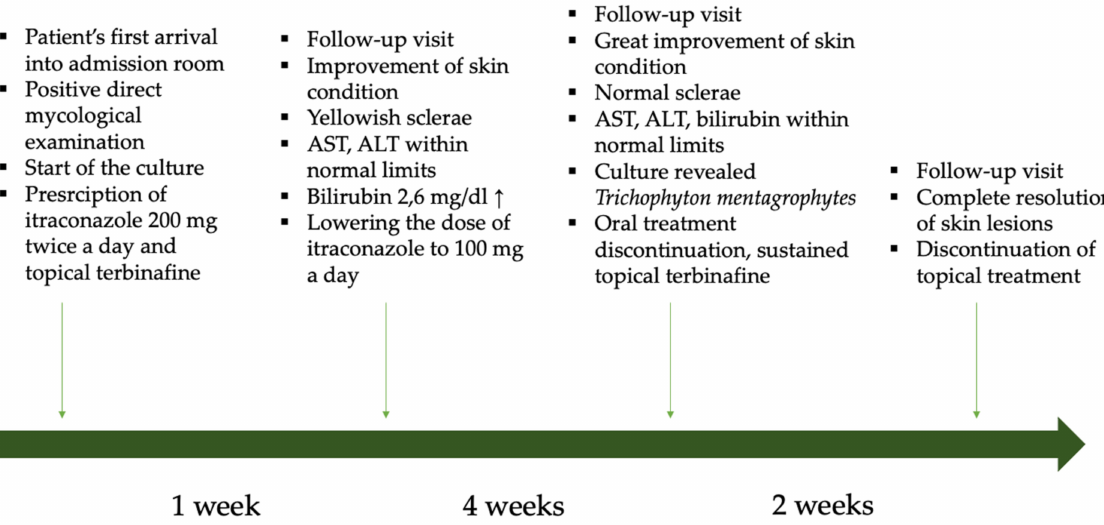
Figure 4. Culture grown from the skin lesions scrapings. Cottony, powdery, cream-beige colonies of Trichophyton mentagrophytes ( a ), with brown pigmentation on the back ( b ). The whole patient’s history is presented in the diagram in Figure 5.